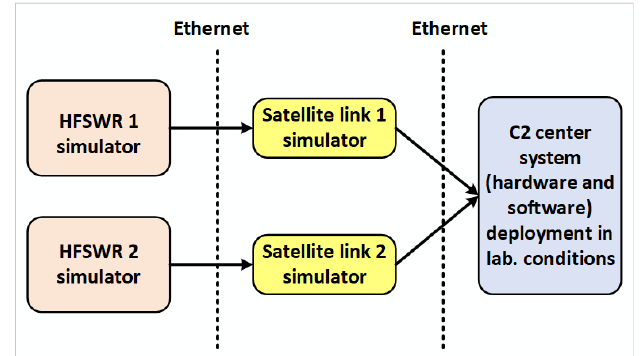
Figure 11. Laboratory setup for use case: the High-Frequency Surface Wave Radars (HFSWR) data fusion.